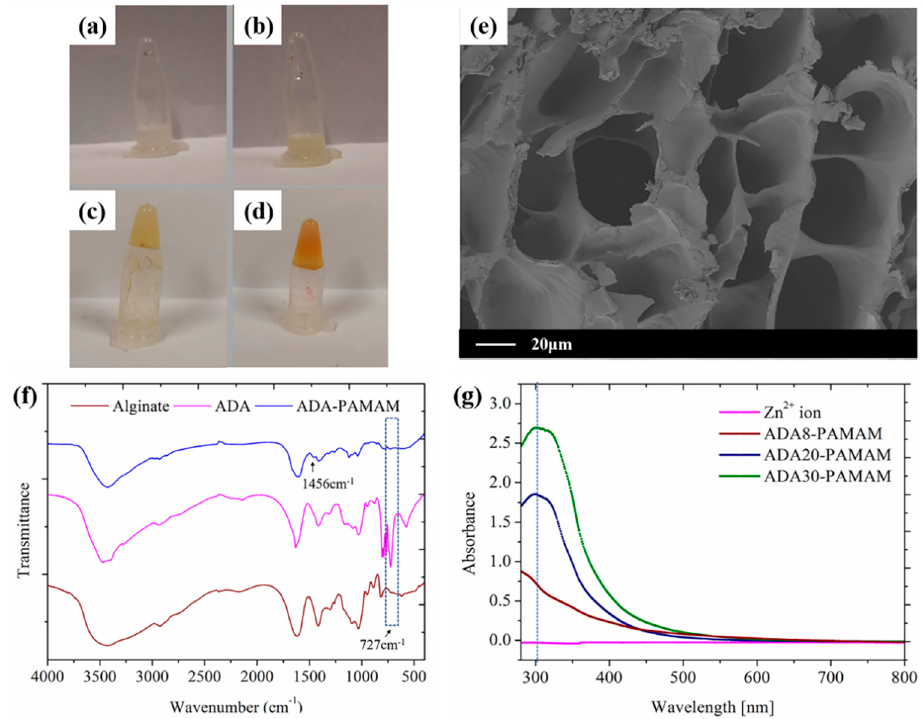
Figure 3. Characterization of ADA-PAMAM. ( a ) refers to 8% oxidized ADA without the introduc- tion of PAMAM. ( b – d ) present ADA-PAMAM, which refers to a mixture of PAMAM with ( b ) non-oxidized alginate, ( c ) 8% oxidized alginate and ( d ) 30% oxidized alginate, respectively. ( e ) Cross section SEM images of ADA-PAMAM ( f ) refers to FTIR spectra of sodium alginate, ADA and ADA-PAMAM, respectively. ( g ) represents the UV spectra of ADA-PAMAM of three different oxidation degrees with the addition of zinc ions.